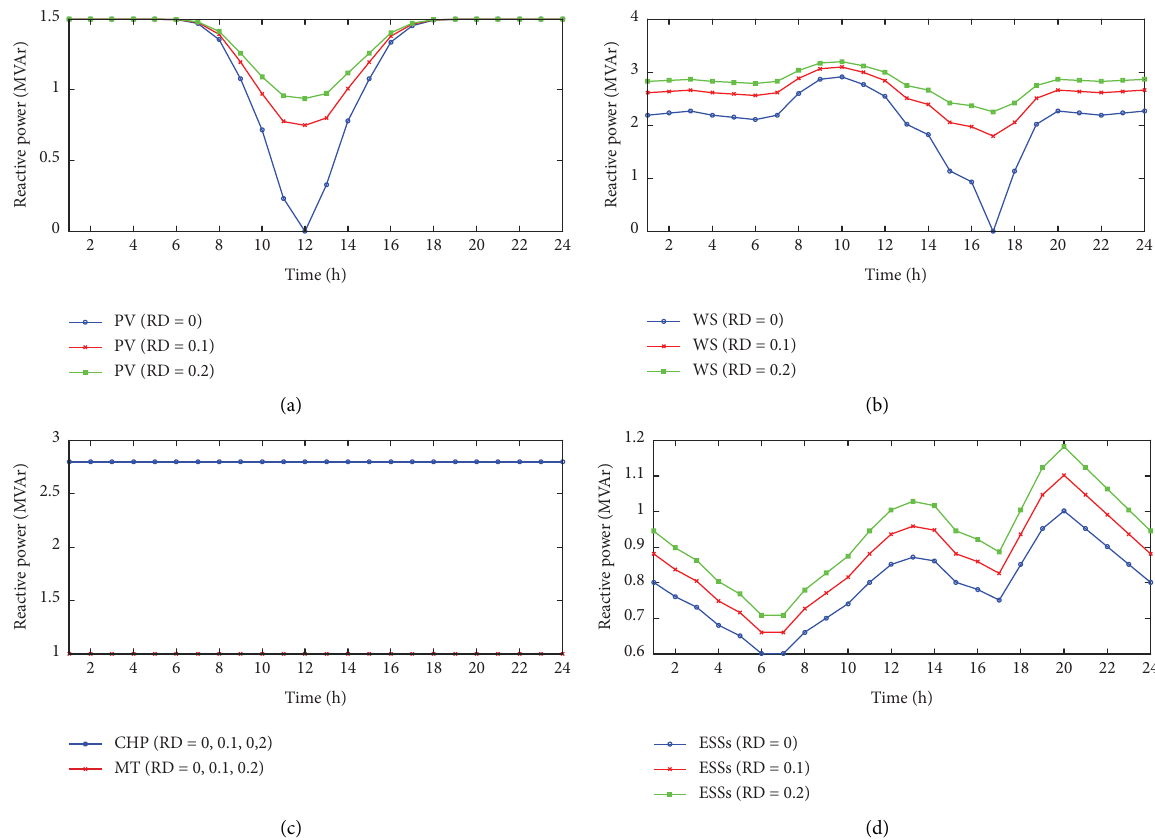
Figure 5: Daily reactive power curve of (a) PVs, (b) WSs, (c) non-RESs, and (d) ESSs in the diferent values of robustness degree.